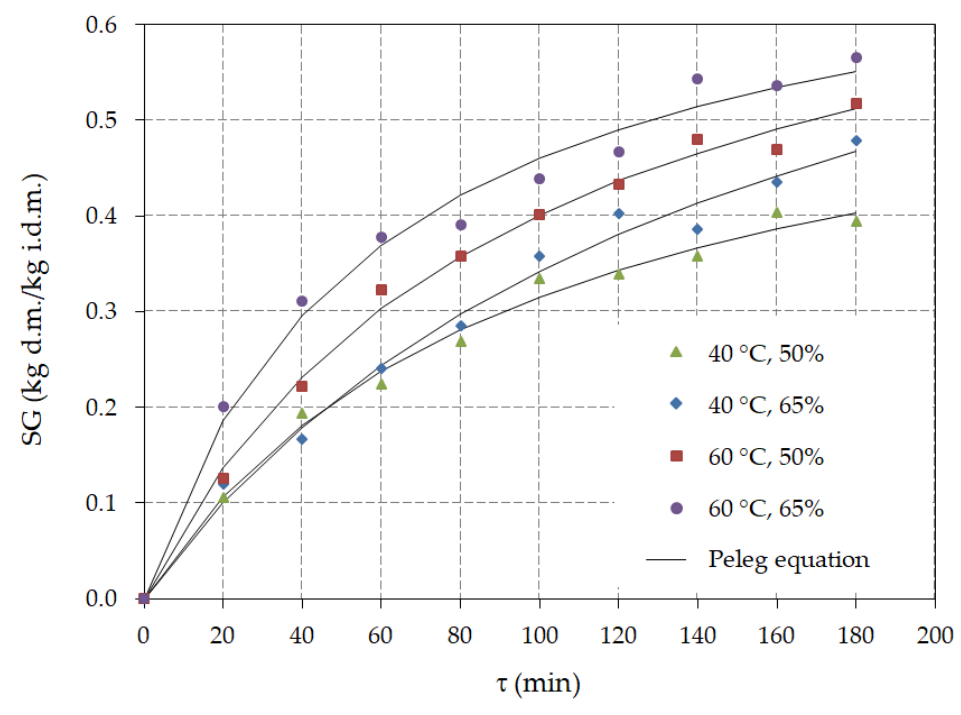
Figure 2. Solid gain (SG) during the osmotic dehydration process (process predicted based on Equation (7)).